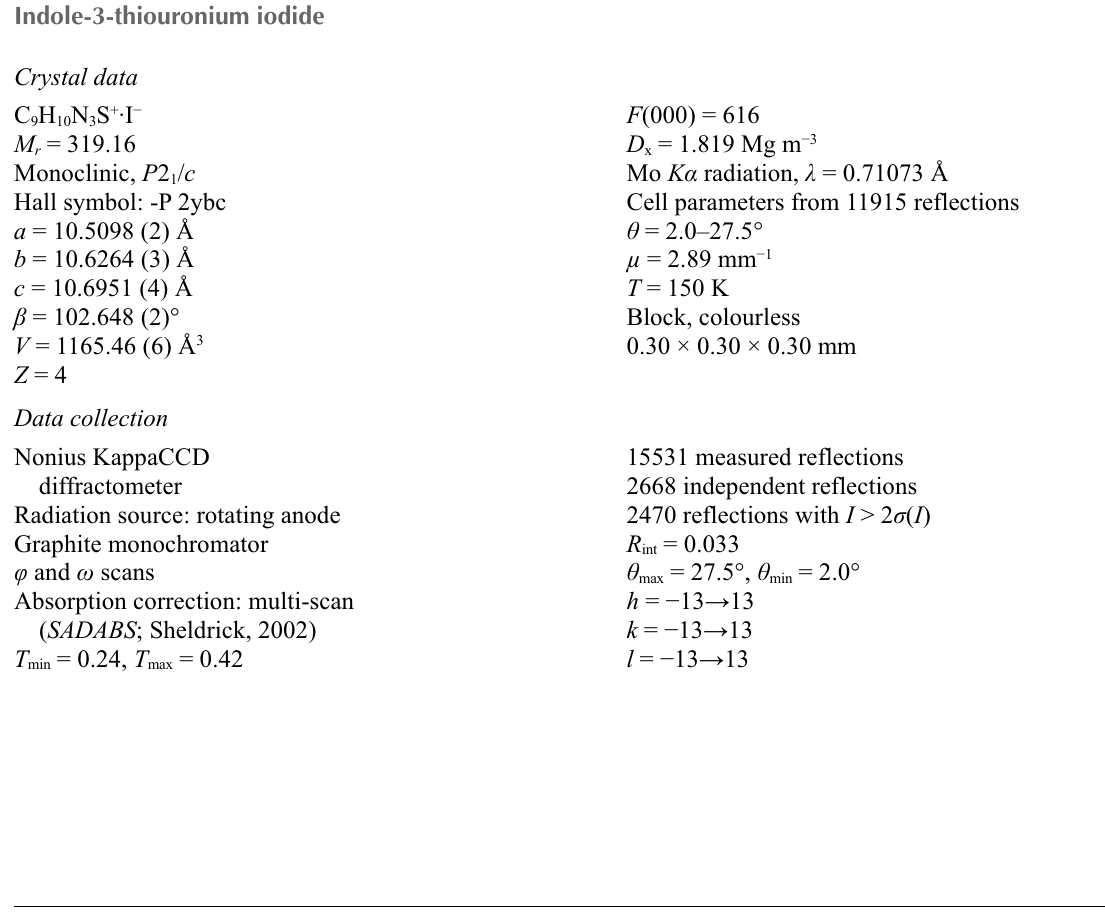
sup-4 Acta Cryst. (2008). E 64 , o195